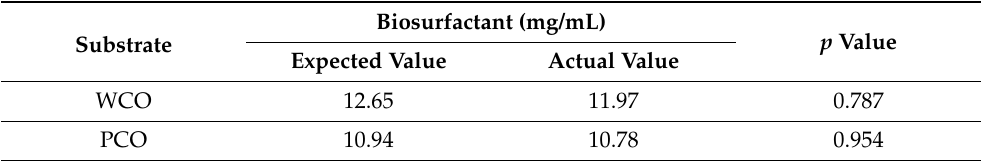
Table 10. Validation of predicted response surface